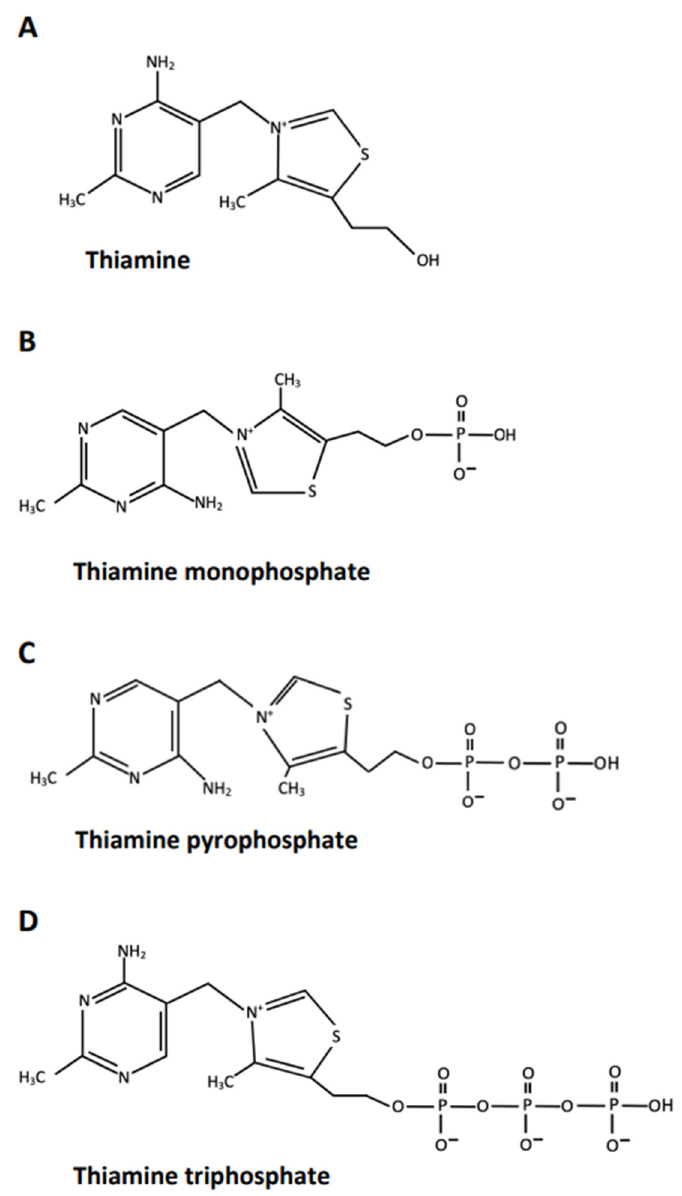
Figure 1. Chemical formula and main biological functions of thiamine and its phosphorylated derivatives. ( A ) Thiamine: dose related antioxidant and anti-inflammatory activity; a role in interneuronal transmission, neural membranes function, and hippocampal neurogenesis. It is not a coenzyme; it has a positive charge. ( B ) Thiamine monophosphate: essential for transfer of thiamine across cellular membranes. It is not a coenzyme; it is a neutral molecule. ( C ) Thiamine pyrophosphate (or diphosphate): It functions as a coenzyme in several biochemical pathways in the brain, essential for synthesis of nucleotides, glutathione, lipids/myelin, ATP for oxidative energy production, several amino acids and some neurotransmitters. TPP also has a direct antioxidant activity per se . It has a negative charge. ( D ) Thiamine triphosphate: may activate high-conductance chloride channels; may have a role in cell energy metabolism. It is not a coenzyme, it has two more negative charges. Thiamine requirement is related to the total caloric intake and the proportion of calo- ries provided as carbohydrates [24]. Thus, high caloric and high carbohydrate diets increase the demand for thiamine. The recommended dose of thiamine for an average, healthy adult is 1.4 mg per day. This dose is higher in children, in critically ill conditions, in individuals with excess metabolic demand, and during pregnancy and lactation [24]. The